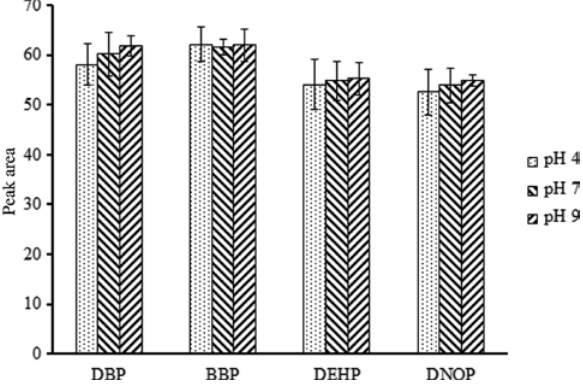
Figure 5: The effects of sample pH on the extraction efficiencies of PEs. (Amount of Fe O @SiO -Ph = 20 mg; sonication time = 30 min; 3 4 2 desorption solvent = methanol; desorption time = 1